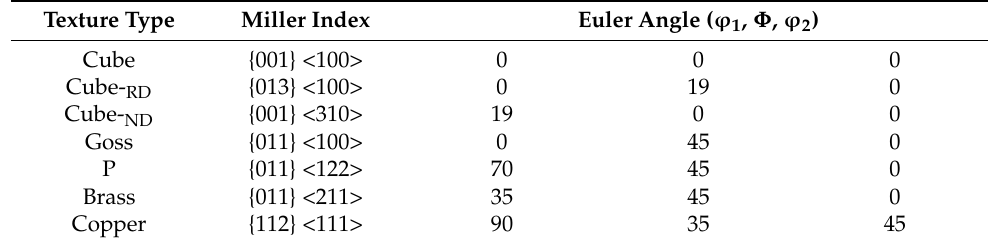
Figure 1. Typical texture ( ϕ 2 = 0 ◦ , 45 ◦ , 65 ◦ ) position in FCC metals. Table 1. Main texture components of FCC Table 1. Main texture components of FCC metals.